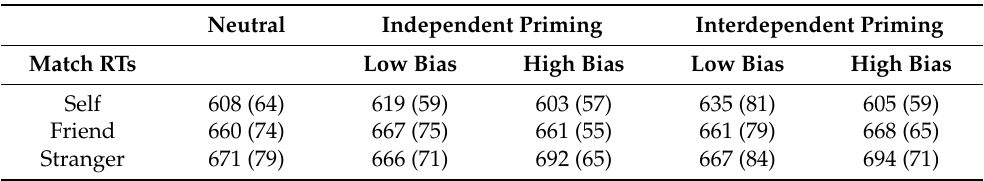
Table 3. Mean RTs and SD (in brackets) for match trials as a function of association, priming, and bias group in Experiment 2.